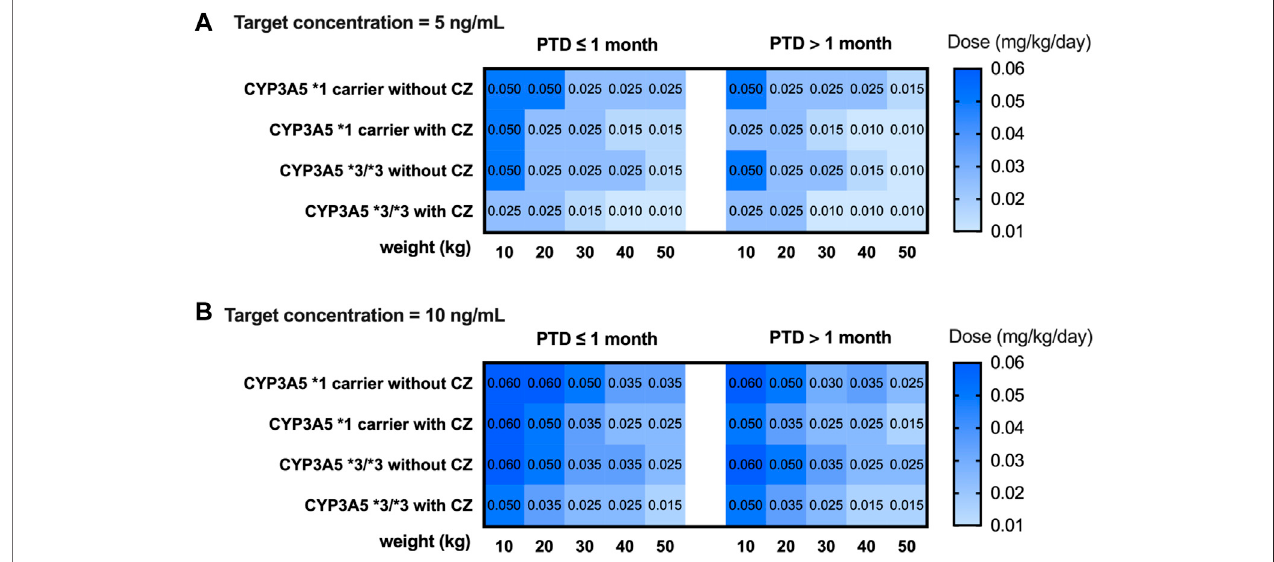
FIGURE 4 | Recommended intravenous dosage of tacrolimus for HSCT children (PTD ≤ 1 month, PTD > 1 month) based on target trough concentration 5 ng/mL (A) and 10 ng/mL (B) . The simulated HSCT children are CYP3A5*1 and CYP3A5*3/*3 carriers with a weight of 10 to 50 kg.